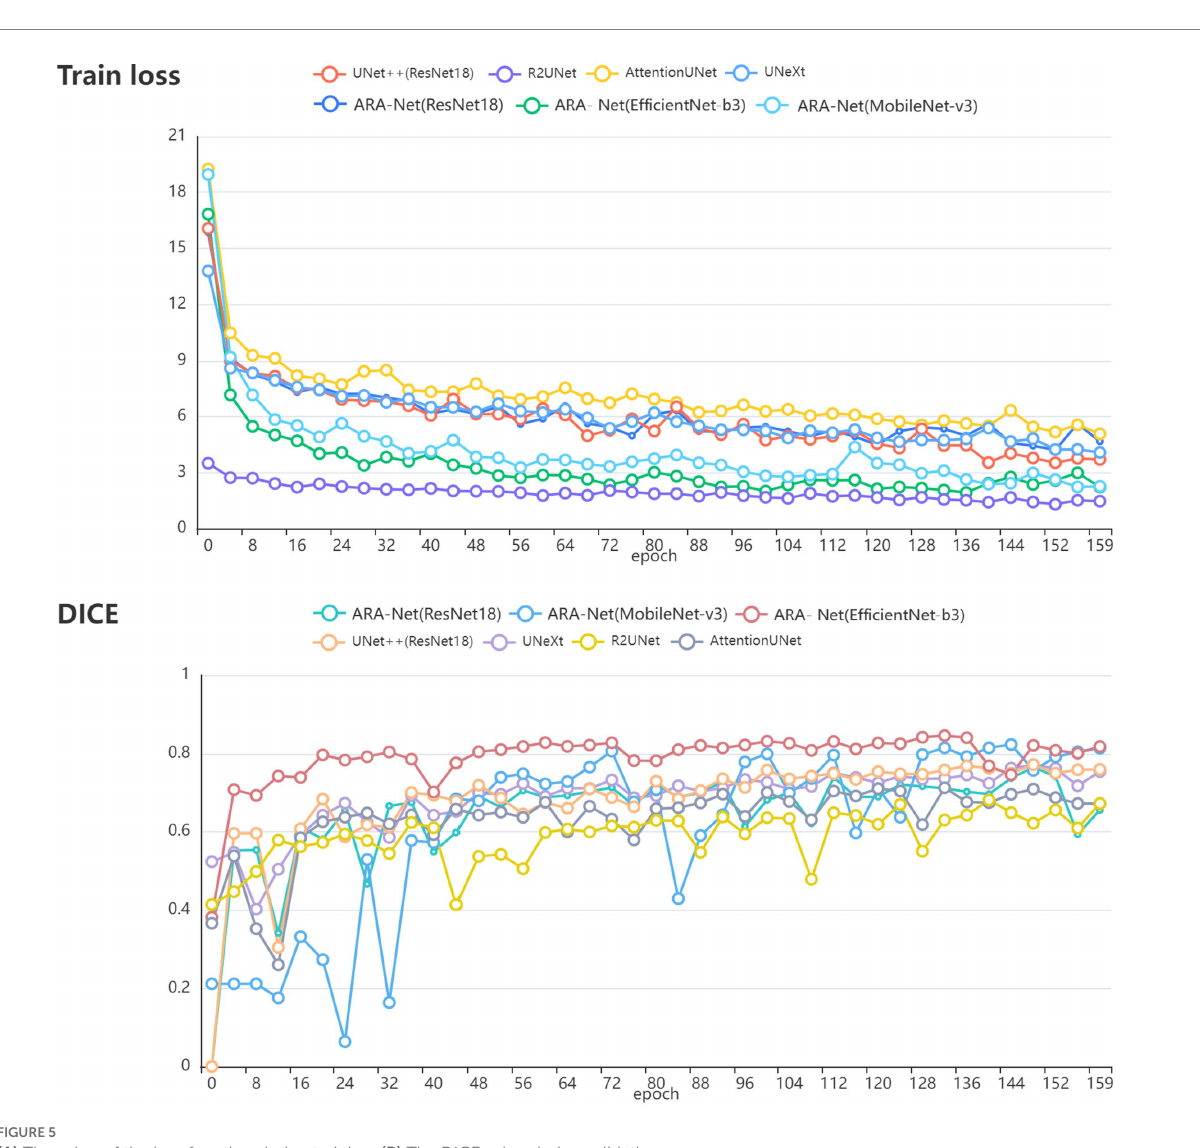
FIGURE 5 (A) The value of the loss function during training. (B) The DICE value during